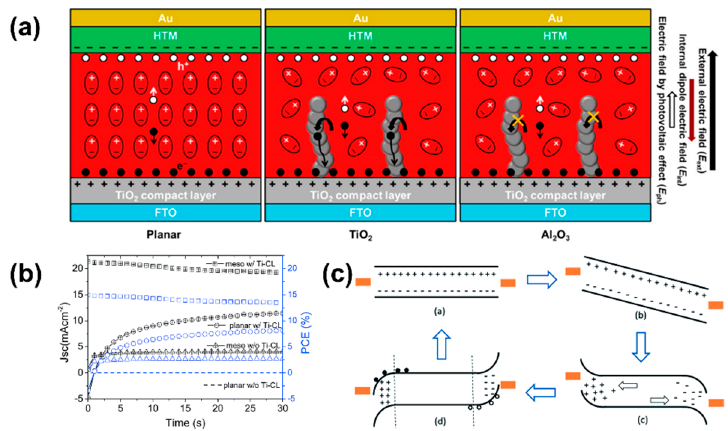
Figure 1. ( a ) Schematic illustration of planar, meso-porous TiO 2 , and Al 2 O 3 scaffolds perovskite device under applied electric field, and plausible physical mechanism of the polarization in ferroelectric perovskite. Reprint with permission [34]; 2015, American Chemical Society. ( b ) Stabilized maximum power point (MPP) measurement with and without compact layer ( c ) Schematic illustration of the ion migration at pre-biased state. Reprint with permission [38]; 2015, Royal Society of Chemistry.